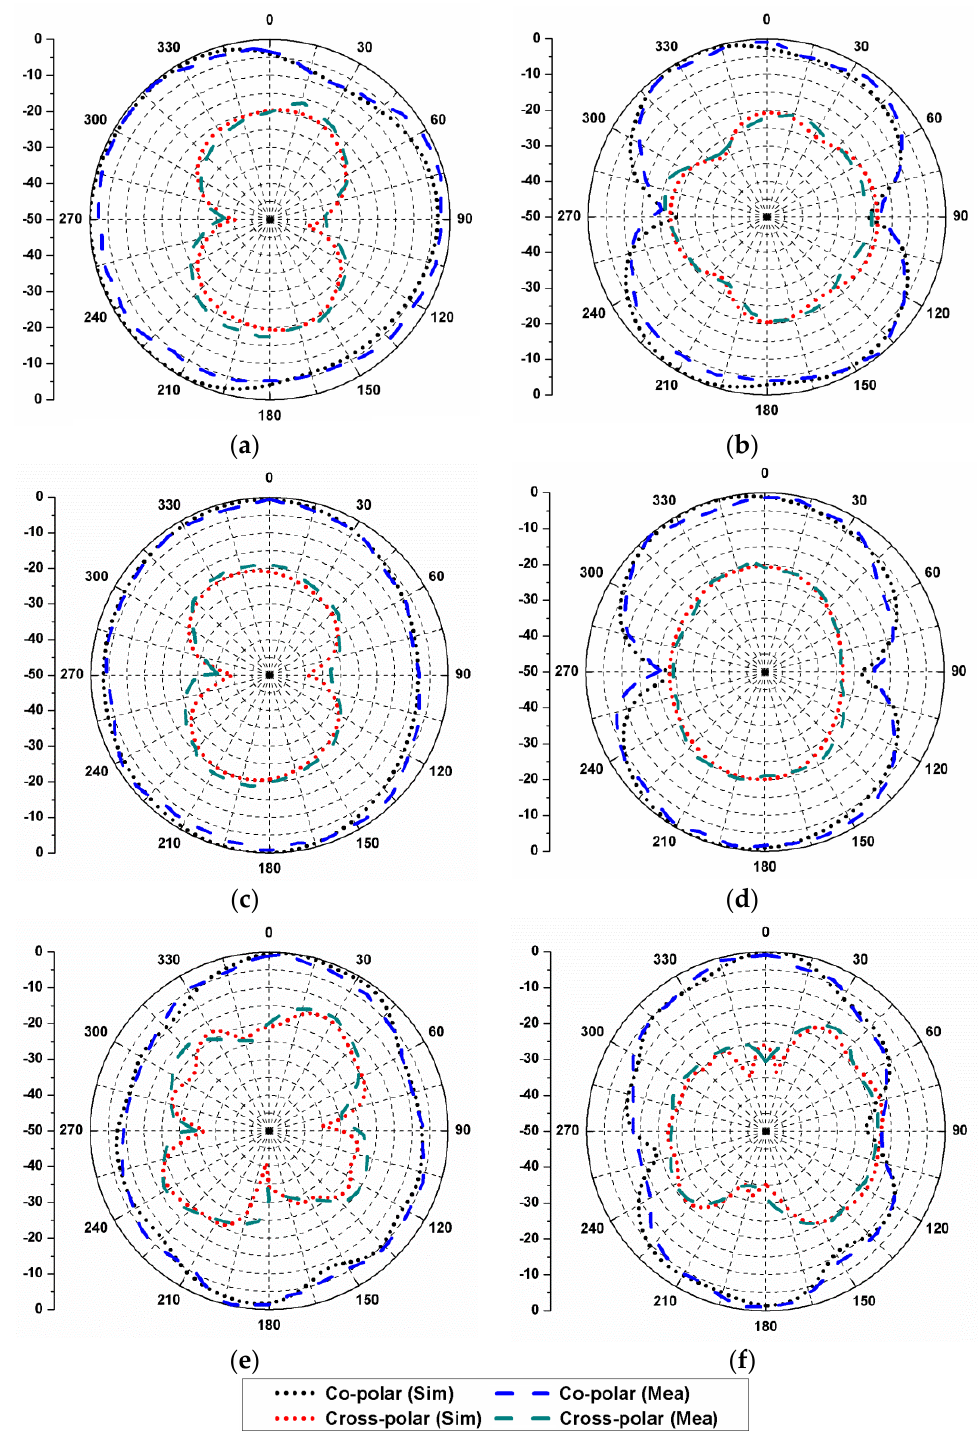
Figure 12. Radiation characteristics of the designed antenna at: ( a ) 5 GHz in H-plane; ( b ) 5 GHz in E-plane; ( c ) 9 GHz in H-plane; ( d ) 9 GHz in E-plane; ( e ) 14 GHz in H-plane; ( f ) 14 GHz in E-plane.